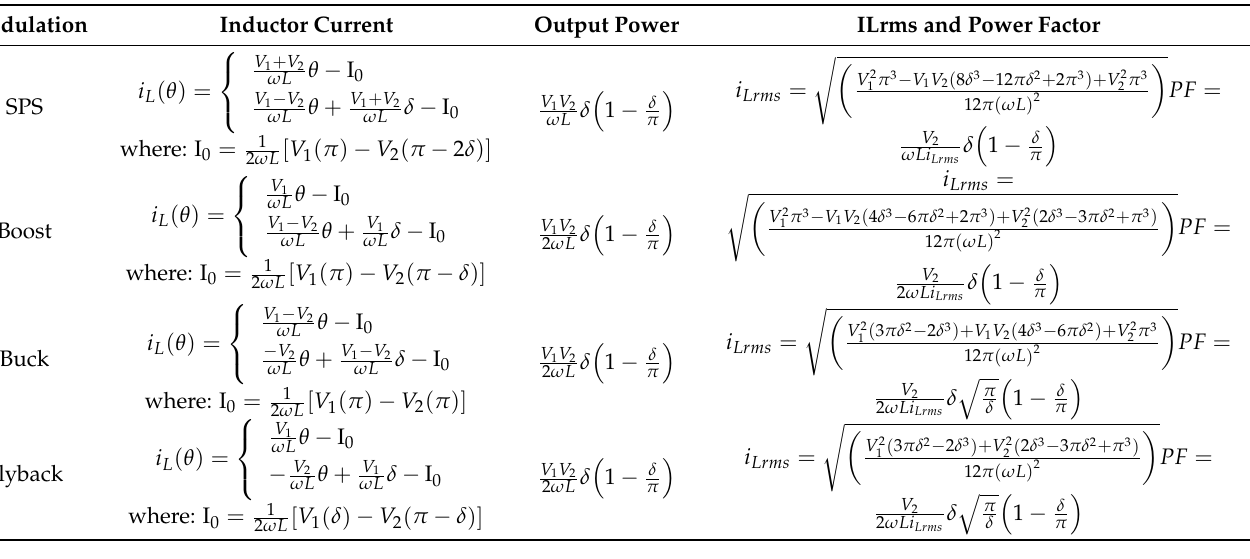
Table 3. Two-stage modulation